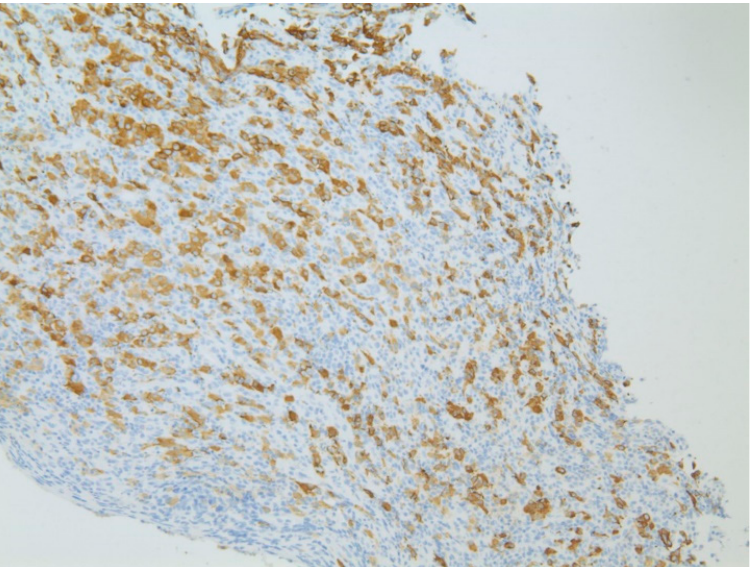
Figure 5. Cytokeratin AE1/AE3 immunostained section showing diffuse infiltration of metastatic renal carcinoma cells (positive expression) noted in a background of gastric stroma (negative expression) at 100× magnification.